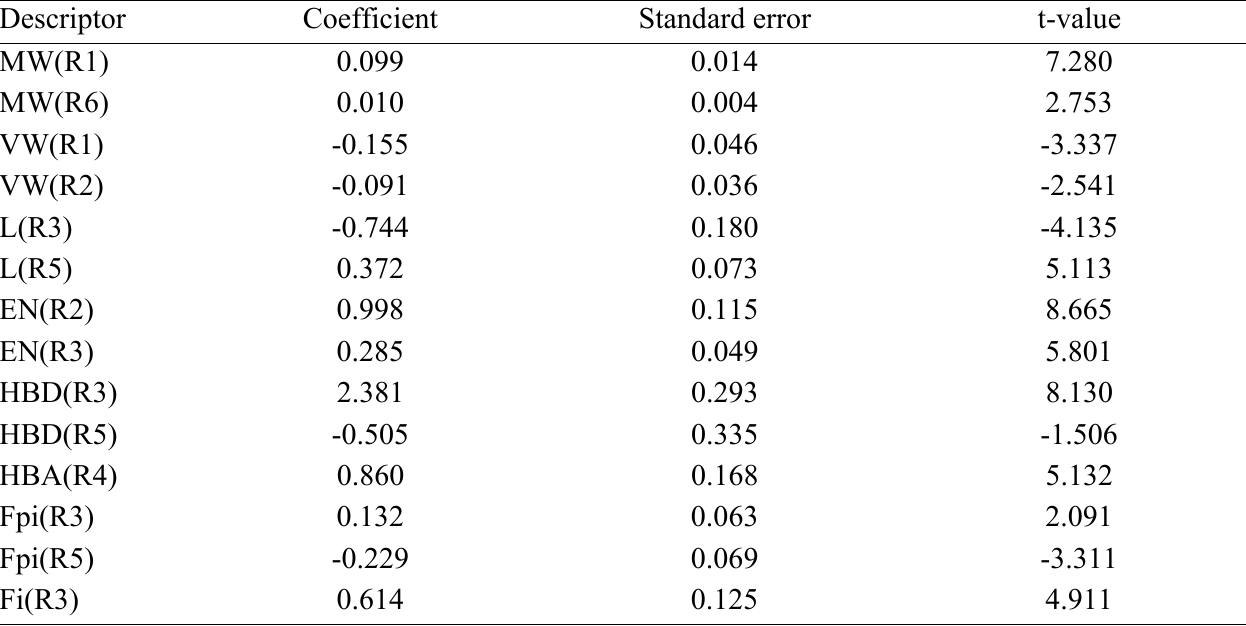
Table 3. t-values of regression equation (1) (ratio of the parameter's regression coefficient and the standard error)